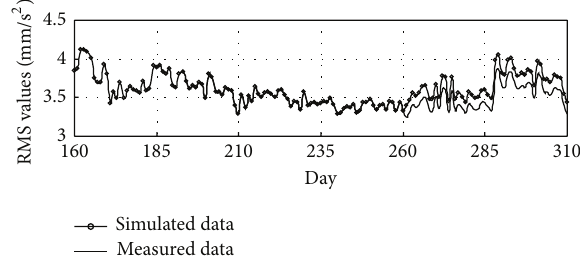
Figure 9: Daily mean values of the measured data and the simulated data of the RMS values of the transverse acceleration data in the middle of the second main